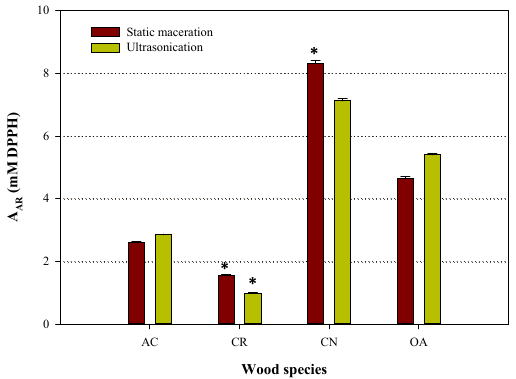
Figure 3. Comparative diagram showing A AR of Tsipouro samples, aged with wooden chips under SM and US. Asterisk denotes statistically different values ( p < 0.05).